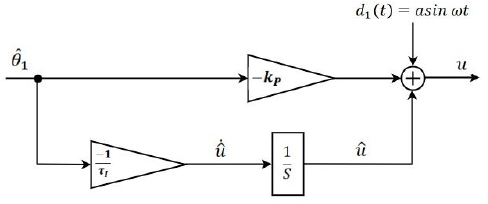
Figure 2. PI controller used for